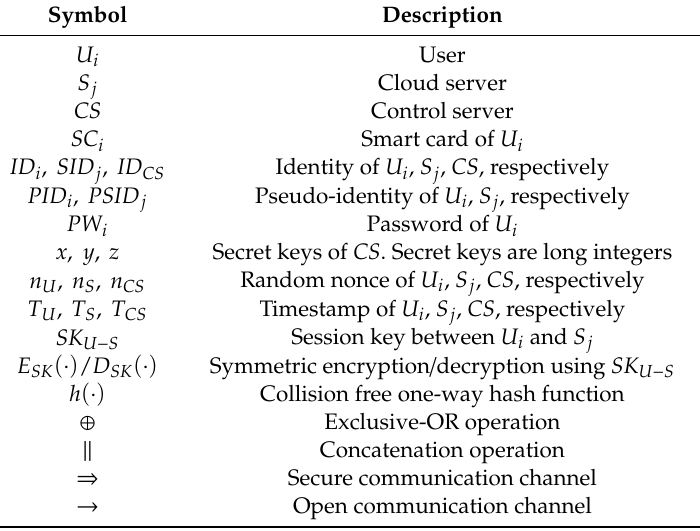
Table 1. Notations of the proposed